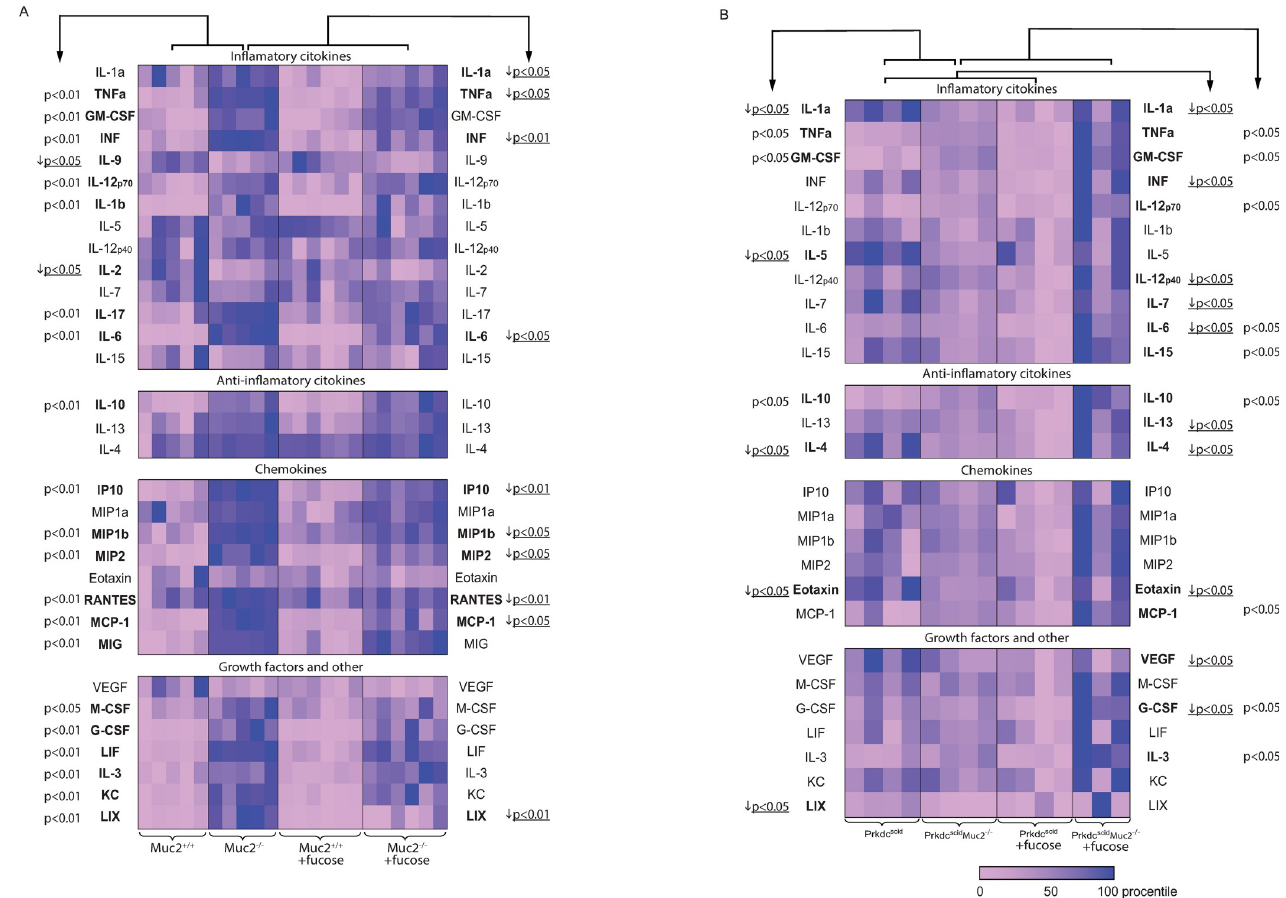
Fig 3. Heat map of cytokine levels in the distal colon. ( � = p < 0.05, �� = p < 0.01, Mann-Whitney u-test). (A) Muc2 −/− and Muc2 +/+ mice with and without L-fucose treatment. (B) Prkdc SCID Muc2 −/− and Prkdc SCID mice with and without L-fucose treatment.